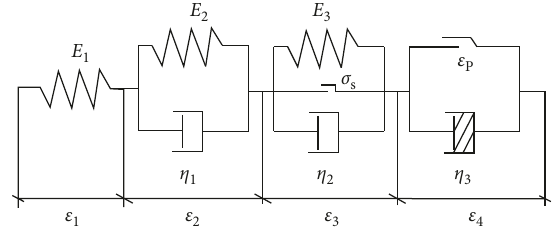
Figure 7: HKCV model. E 1 is the instantaneous elastic modulus. E 2 and E 3 are the viscoelastic moduli. η 1 , η 2 , and η 3 are the viscoelastic coefficients. ε 1 , ε 2 , ε 3 , and ε 4 are the strains corresponding to the rheological bodies. σ S is the yield stress of rock. ε P is the strain value at the boundary point between the stable rheological stage and the accelerated rheological